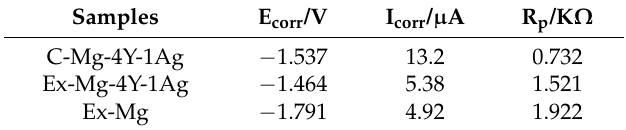
Table 2. Electrochemical parameters of C-Mg-4Y-1Ag, Ex-Mg-4Y-1Ag, and Ex-Mg.